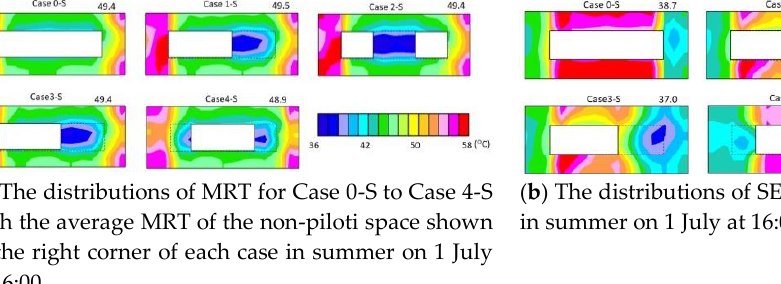
Figure 9. The MRT and SET* results for the piloti arrangements in summer.